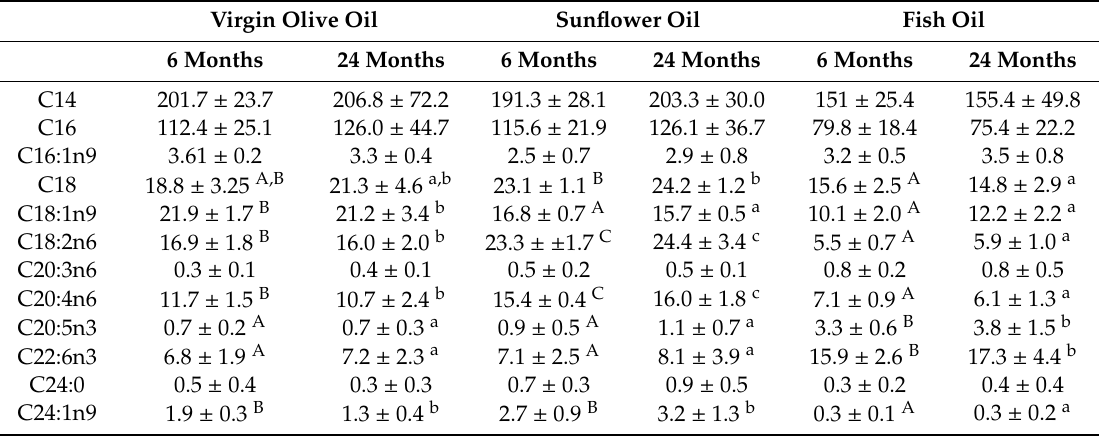
Table 1. Heart mitochondrial membrane fatty acid profile ( µ g / mg) in rats fed for 6 or 24 months on virgin olive oil, sunflower oil or fish